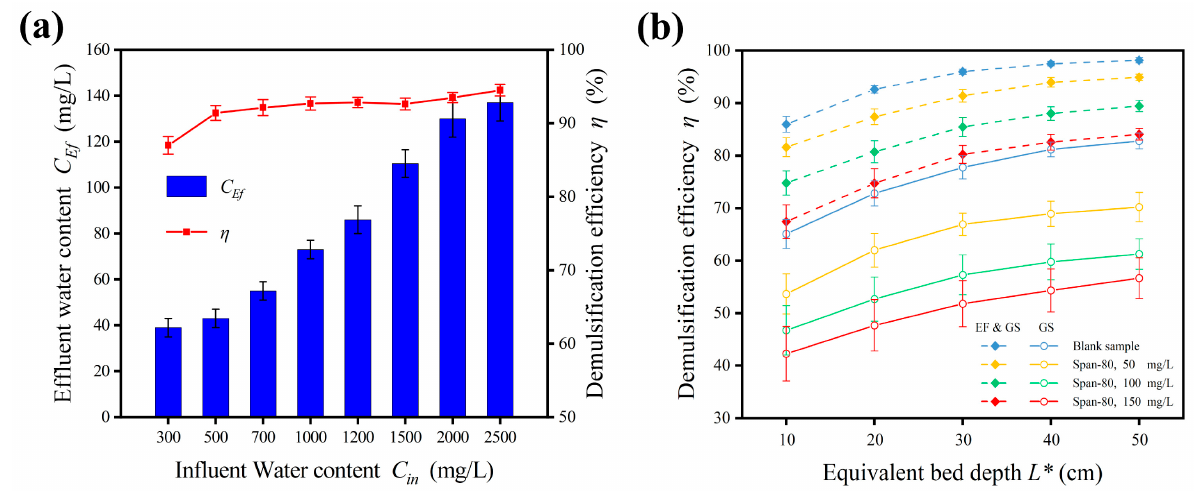
Figure 8. Effects of W/O emulsion characteristics. ( a ) Effect of surfactant concentration. ( b ) Effects of influent water content. Conditions: C in = 300–2500 mg/L; v = 0.001 m/s; U = 0 or 3 kV; GS medium bed with size of 1.0–2.0 mm and L* = 20cm.